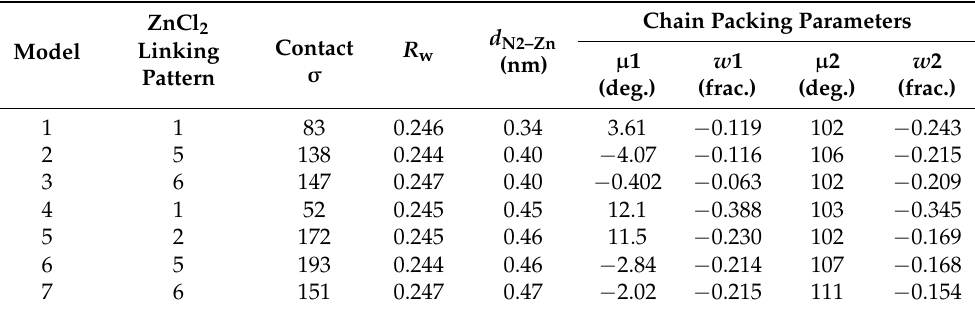
Table 4. Chain packing parameters, R w , and nonbonding contacts of final refined models.